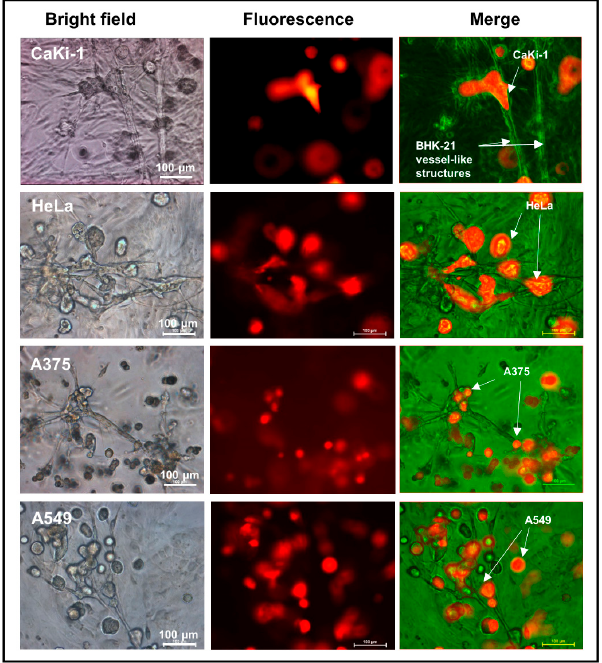
Figure 4. Propensity of the cancer cells to adhere to the fibroblast vessel-like structures in a 3D Matrigel suspension. Representative images showing adherence of RFP-labelled cancer cells (CaKi-1, HeLa, A375 and A549) to BHK-21 vessel-like structures in Matrigel droplets 4 days after the cells were seeded. Biology 2020 , 9 , x FOR PEER REVIEW